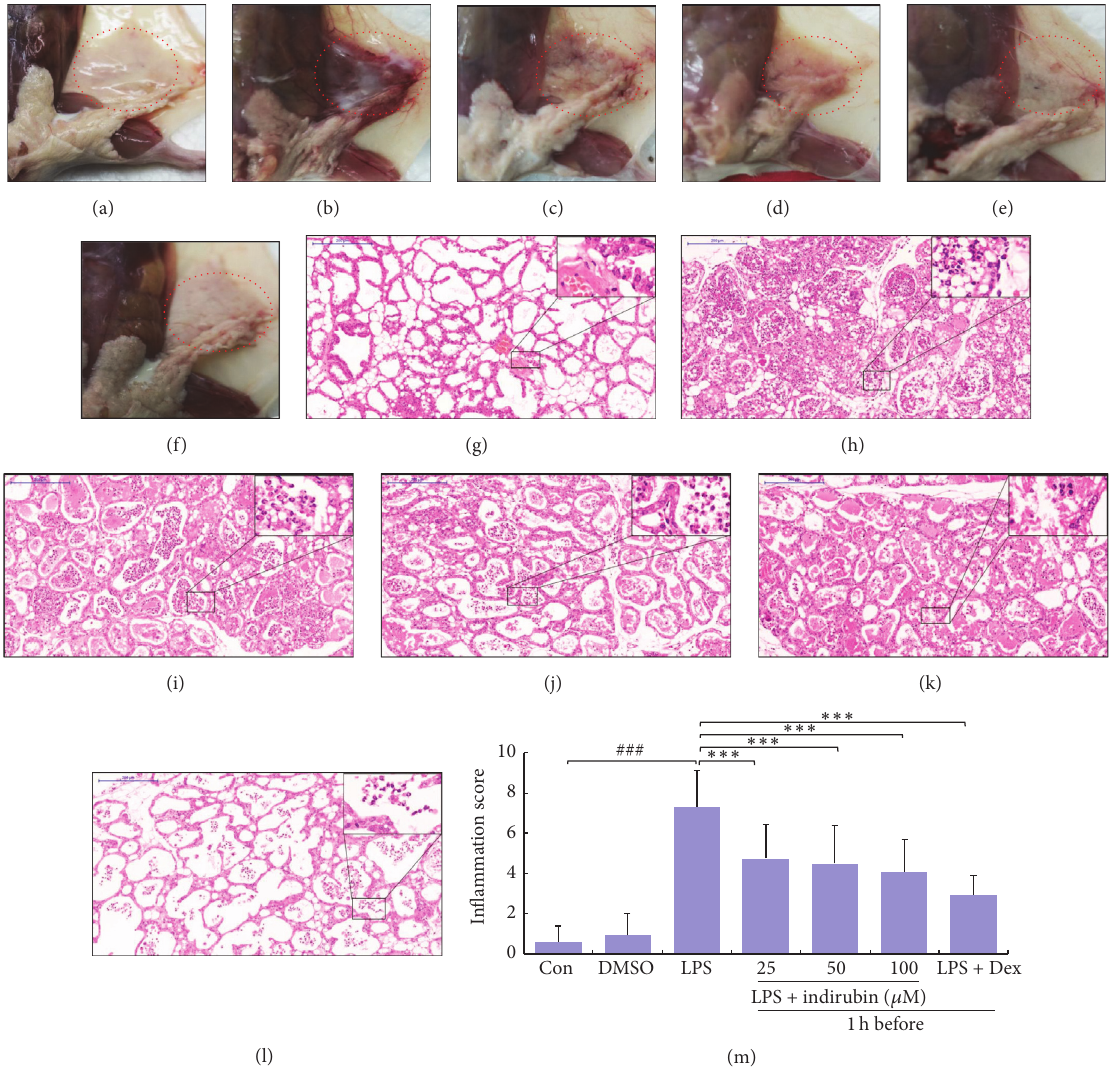
Figure 1: Effect of indirubin on the macroscopic pathology and histological changes in LPS-induced mouse mastitis. Representative macroscopic (a–f) and histological (g–l) changes in mammary glands from the (a, g) control, (b, h) LPS, (c, i) LPS + indirubin (25 𝜇 M), (d, j) LPS + indirubin (50 𝜇 M), (e, k) LPS + indirubin (100 𝜇 M), and (f, l) Dex groups (histological changes observed at 100x magnification; the insets are 400x magnification). (m) Major mammary score ( ### 𝑝 < 0.001 versus control group; ∗∗∗ 𝑝 < 0.001 versus LPS